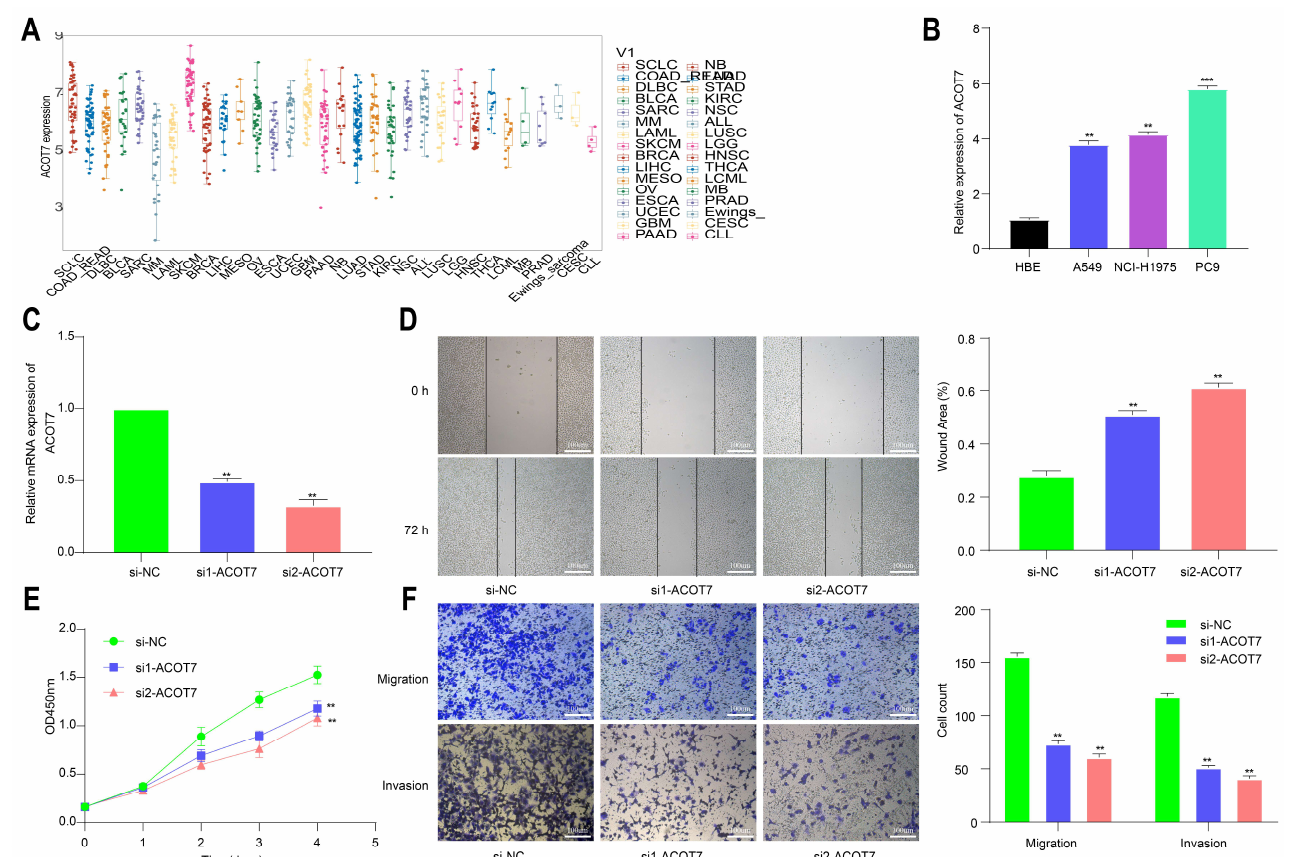
Figure 11. Knockdown of ACOT7 inhibited proliferation and progression in lung cancer cells. ( A ) ACOT7 expression in cancer cells via CCLE. ( B ) The expression level of ACOT7 in HBE and various lung cancer cell lines via qRT-PCR. ( C ) Transfection of PC9 cells with si-ACOT7 and the efficacy was verified via qRT-PCR. ( D ) Scratch assays. ( E ) CCK-8 assays. ( F ) Transwell and Matrigel assays. ** p < 0.01, *** p < 0.001.